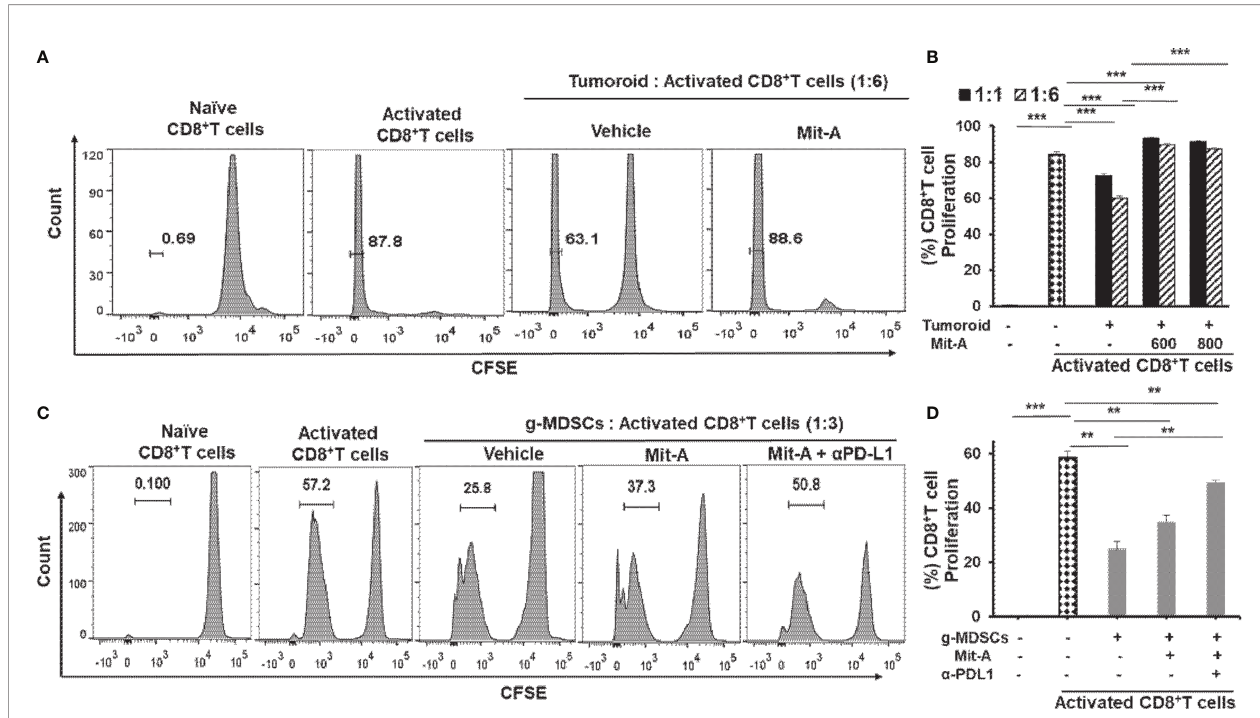
FIGURE 2 | Mit-A enhances proliferation of activated CD8 + T cells and reverses the immunosuppression of tumoroid culture and g-MDSCs in combination with a PD-L1 mAb treatment. (A, B) CD8 + T cells isolated from naïve C57BL/6 mouse spleen were stained with CFSE proliferation dye, stimulated using CD3/CD28 activation beads and co-cultured with biopsy tumoroid (on Day 4 of tumoroid culture) in presence of IL-2 (30 U/ml). Mit-A was added to the co-culture immediately post T cell addition at various ratios to tumoroid cultures and T cell proliferation assessed by fl ow cytometry 72 h post addition. CFSE plots are shown in (A) and percent T cell proliferation plotted in (B) . (C, D) The sorted g-MDSCs isolated from the spleen of orthotopic MC38 tumor bearing mice were co-cultured with CFSE- labelled activated CD8 + T cells in 1:3 ratio (g-MDSC:T cells) in presence of Mit-A (600 nM) with or without a PD-L1 mAb (20 µg/ml). T cell proliferation was assessed by fl ow cytometry 72 h post treatment. CFSE plots are shown in (C) and percent T cell proliferation plotted in (D) . Data analyzed as mean ± SEM by Student ’ s t-test. **p < 0.01, ***p < 0.001. A representative of three experiments is